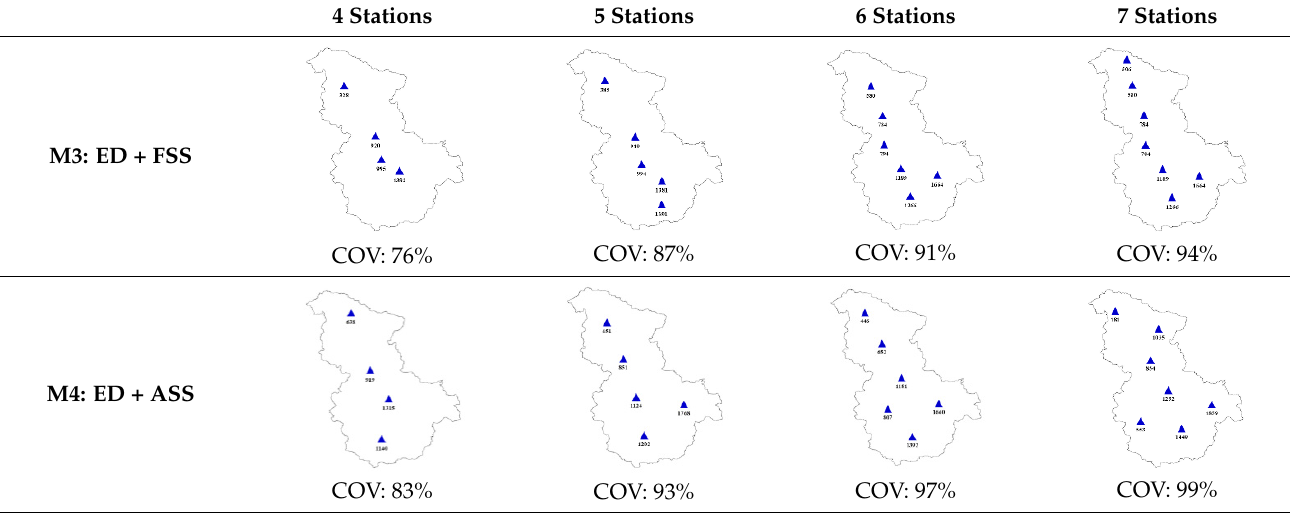
Map of Sejong city